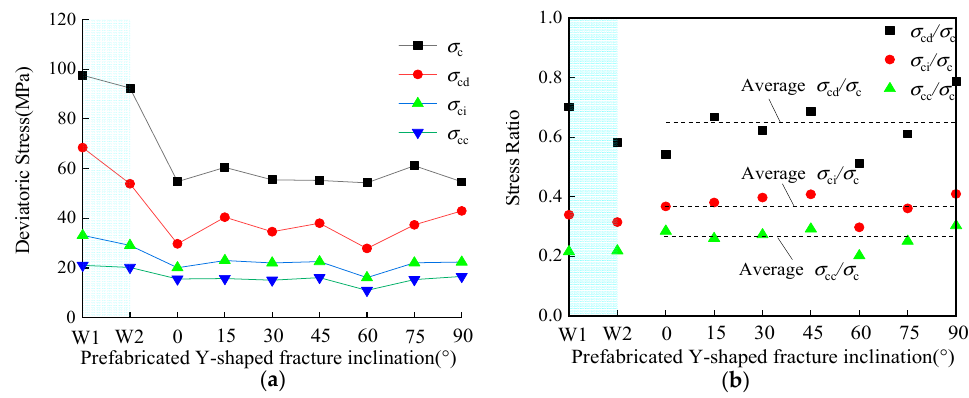
Figure 10. Relationship between the fracture inclination and different thresholds, and the stress ratios of the intact and Y-shaped fracture samples: ( a ) relationship between the different thresholds and fracture inclination and ( b ) relationship between the stress ratio and fracture inclination.